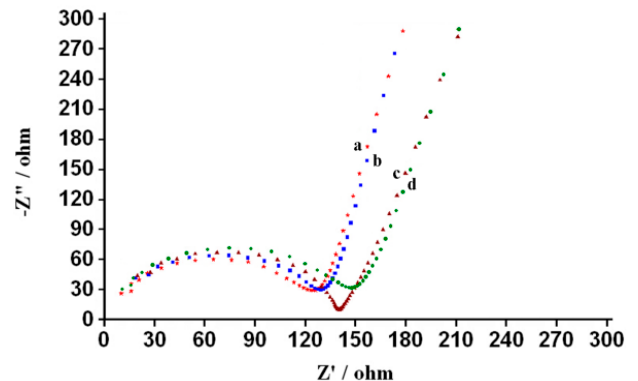
Figure 5. Electrochemical impedance spectra of electrode: nafion/Fe 3 O 4 -NCs/GCE (a, solid star), nafion/GCE (b, solid square), Fe 3 O 4 -NCs/GCE (c, solid triangle) and bare/GCE (d, solid circle).